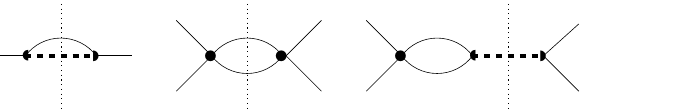
Figure 3. The Feynman graphs contributing to the STP parameters. The horizontal dashed line connects the two clusters of the bi-local vertices which couple the bra and the ket.